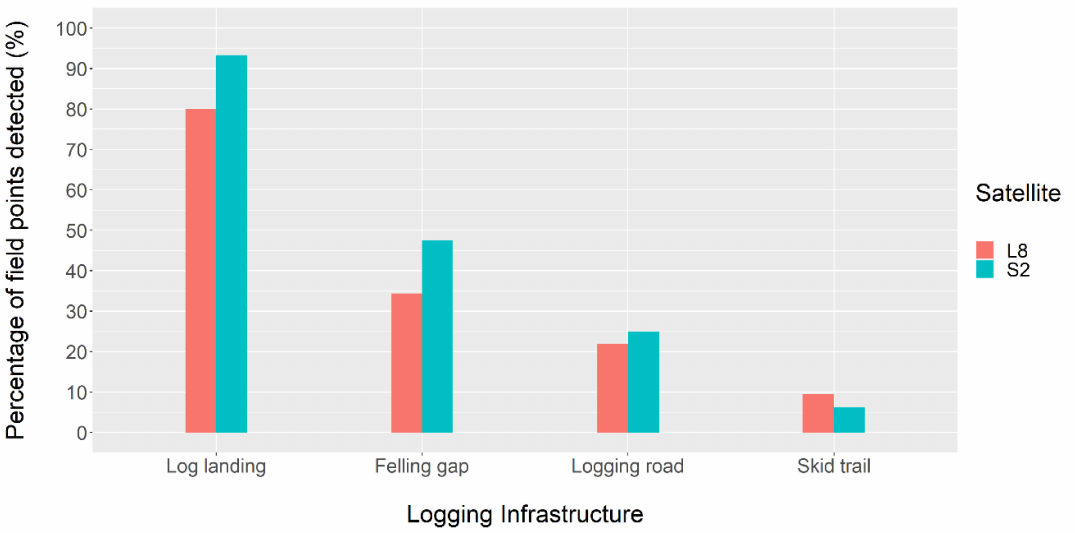
Figure 6. Percentage of disturbed field points correctly detected according to satellite imagery and four types of logging disturbances. L8 = Landsat 8; S2 =